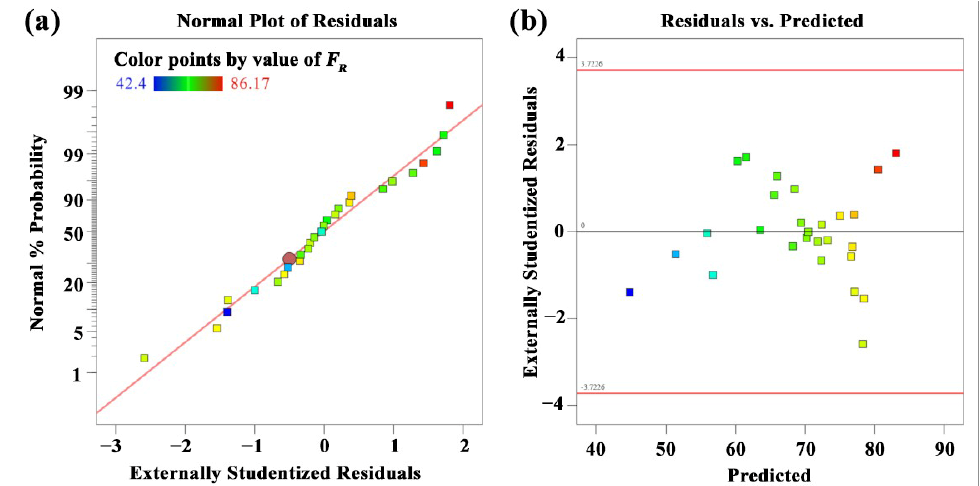
Figure 2. ( a ) Normal distribution of experimental data ( b ) predicted value with residuals.